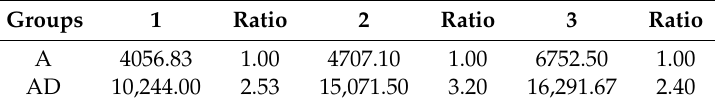
Table 6. Modulus of elasticity of TMFG.